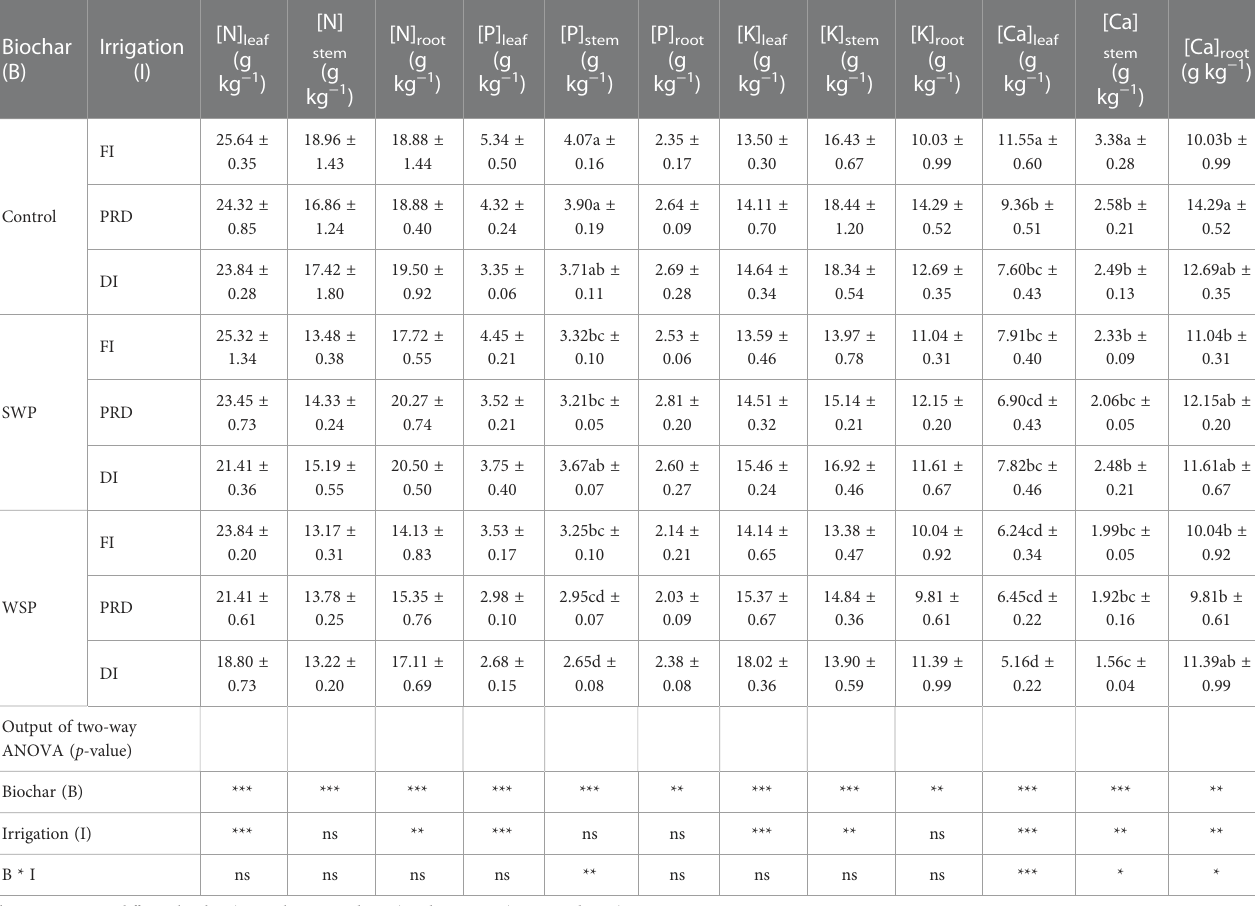
TABLE 5 The effects of treatments and output of two-way ANOVA for [N] leaf , [N] stem , [N] root , [P] leaf , [P] stem , [P] root , [K] leaf , [K] stem , [K] root , [Ca] leaf , [Ca] stem , and [Ca] root of maize